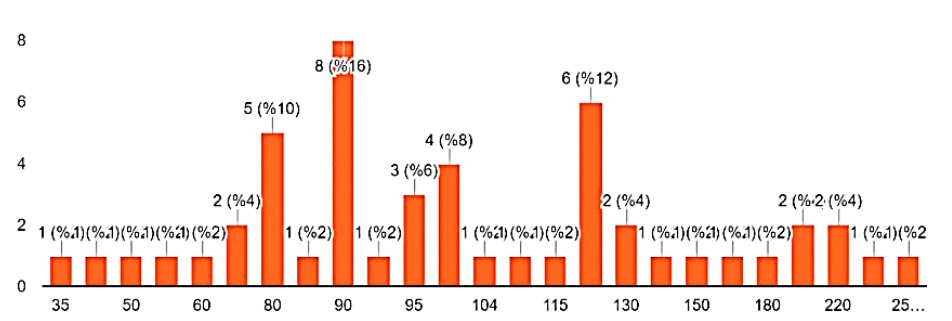
Figure 15 Distribution of residential square meters by persons (Question: How many square meters is your